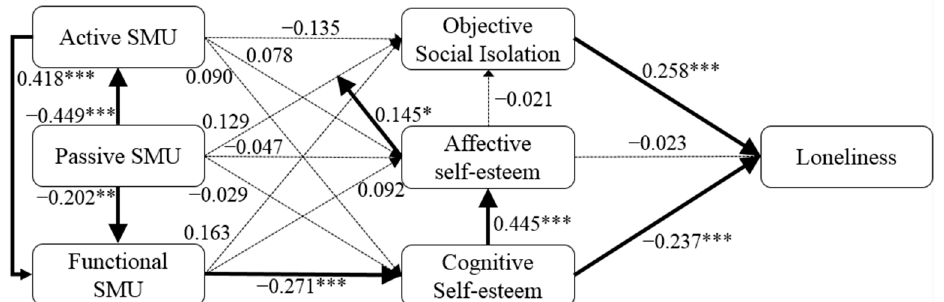
Figure 1. PLS-SEM results for the relationship between SMU patterns and older adults’ loneliness. Notes: SMU, social media usage; thick solid lines indicate significant effects, and thin dashed lines indicate insignificant effects; significance was assessed with the bootstrapping method (N = 2000); * p < 0.05, ** p < 0.01, and *** p < 0.001. In terms of the antecedents of FSMU, ASMU (b = 0.418, t = 5.643, p < 0.001) and PSMU (b = − 0.202, t = 3.120, p < 0.01) had a significant effect on FSMU, providing support for